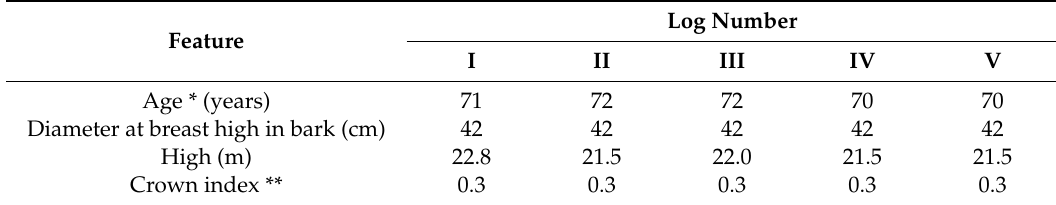
Table 1. Characteristics of experimental trees of silver birch ( Betula pendula